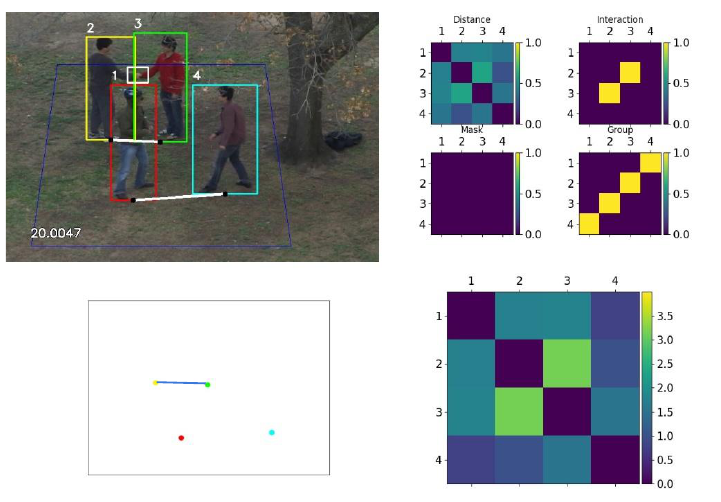
Figure 12. Full system result of UTI interaction dataset at t 3 .